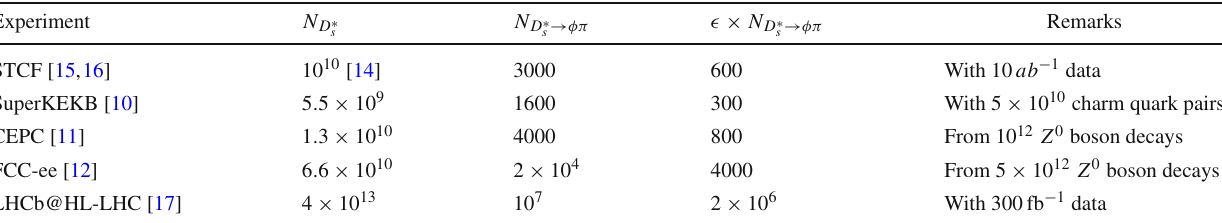
Table 1 The potential event numbers of the D ∗ s meson available and the D ∗ s → φπ decays in the future experiments, with the branching ratio B ( Z 0 → c ¯ c ) ≈ 12% [2] and B ( D ∗ s → φπ) ≈ 3 × 10 − 7 ,